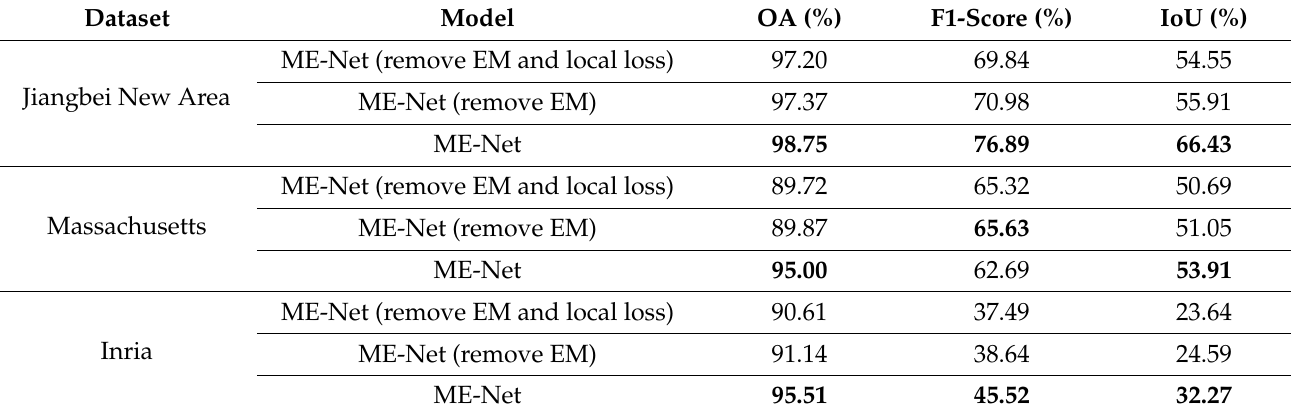
Table 8. Ablation analysis evaluation results of ME-Net, the best values of each dataset are masked as bold.